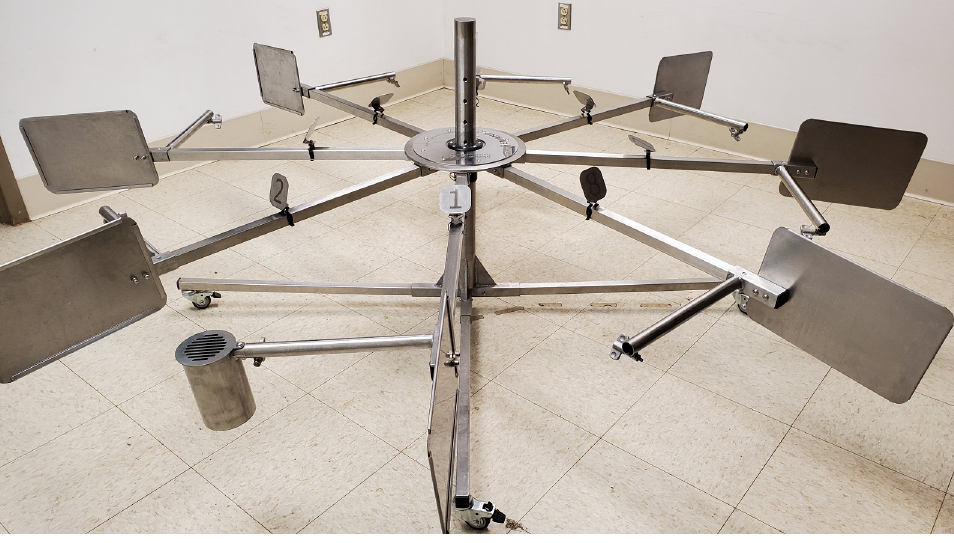
Fig 2. Photograph of the 8-port stainless-steel scent wheel used in this study (manufactured by DEMAND (design & manufacture for disability), Abbots Langley, UK, http://www.demand.org.uk). Ports which held the odors moved between arms of the wheel for example, in “1” there is a port present–all other arms are empty.